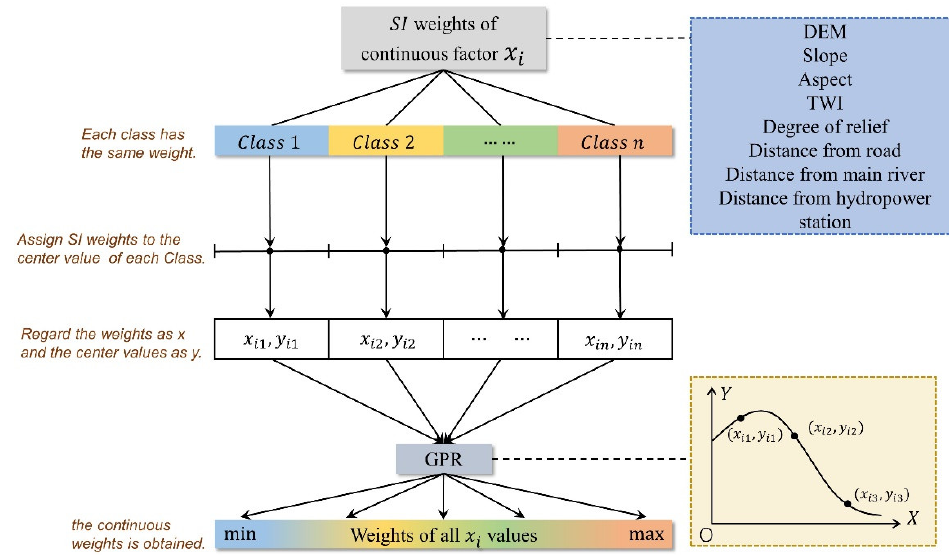
Figure 7. The algorithm for optimizing the SI model by Gaussian process regression.